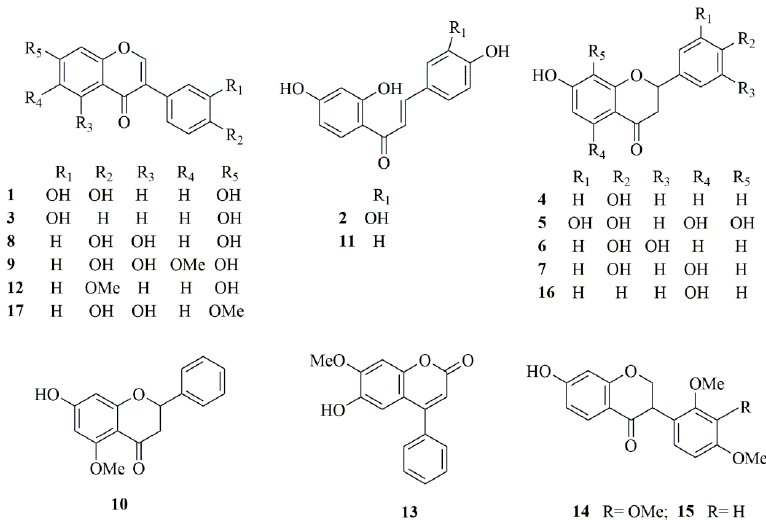
Figure 1. Chemical structures of the seventeen target compounds. 1, 3 ′ -Hydroxydaidein; 2, Butein; 3, Daidzein; 4, Liquiritigenin; 5, Eriodictyol; 6, Butin; 7, Naringenin; 8, Genistein; 9, Tectorigenin; 10, Alpinetin; 11, Isoliquiritigenin; 12, Formononetin; 13, Dalbergin; 14, 3 ′ - O -methylviolanone; 15, Sativanone; 16, Pinocembrin; 17, Prunetin. Analytes numbers in the test is the same as in this figure.